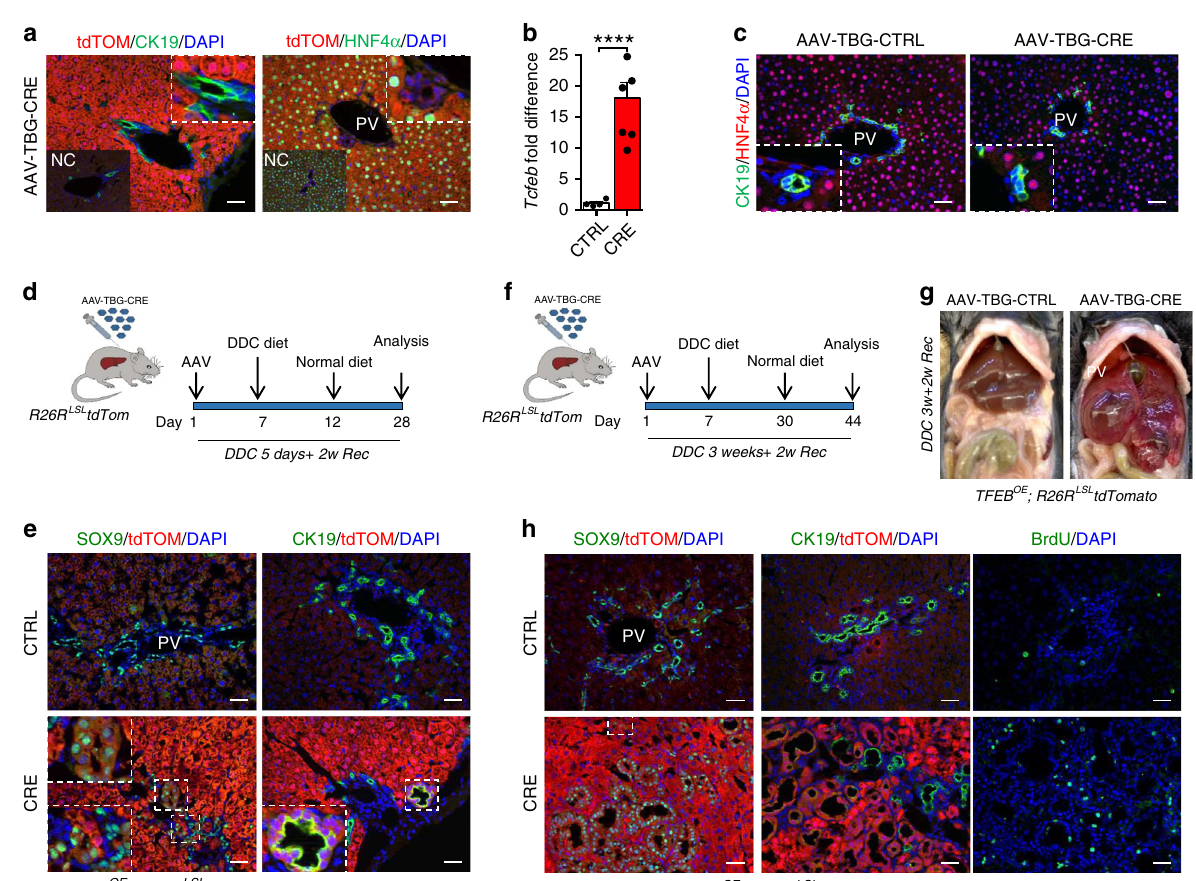
Fig. 7 TFEB-overexpressing hepatocytes dedifferentiate in progenitor/cholangiocyte-like cells upon liver injury. a tdTom/CK19 and tdTom/HNF4 α immuno fl uorescence in AAV8-TBG-CRE-treated livers 4 weeks after injection. CRE-treated HNF4 α + hepatocytes are tdTom + in contrast to CK19 + ductal cells located in the portal tract (PV). Insets: images of AAV-CTRL injected liver indicated as negative control (NC). Scale bar 50 μ m. b Transcript levels of Tcfeb in livers isolated from AAV8-TBG-CRE-treated mice 4 weeks after injection (CTRL n = 4, CRE n = 6 biological replicates). Tcfeb mRNA levels were normalized to the CTRL. Data are represented as mean ± SEM. **** p ≤ 0.0001 two-tailed Student ’ s t -test. c CK19/HNF4 α immuno fl uorescence analysis in AAV8-TBG-CRE-treated and CTRL liver 4 weeks after injection showing no alteration in cell identity. Scale bar 50 μ m. d Experimental design of the AAV8 injection followed by acute liver injury protocol. e Fourteen days post DDC acute injury hepatocytes dedifferentiate in progenitor/biliary cells. f Experimental design of the AAV8 injection followed by chronic liver injury protocol. g Gross appearance of AAV-injected livers from day 14 of recovery after DDC prolonged exposure. h Immuno fl uorescence analysis of AAV8-treated livers at day 14 of recovery after DDC diet. Scale bar 50 μ m. Source data are provided as a Source Data fi